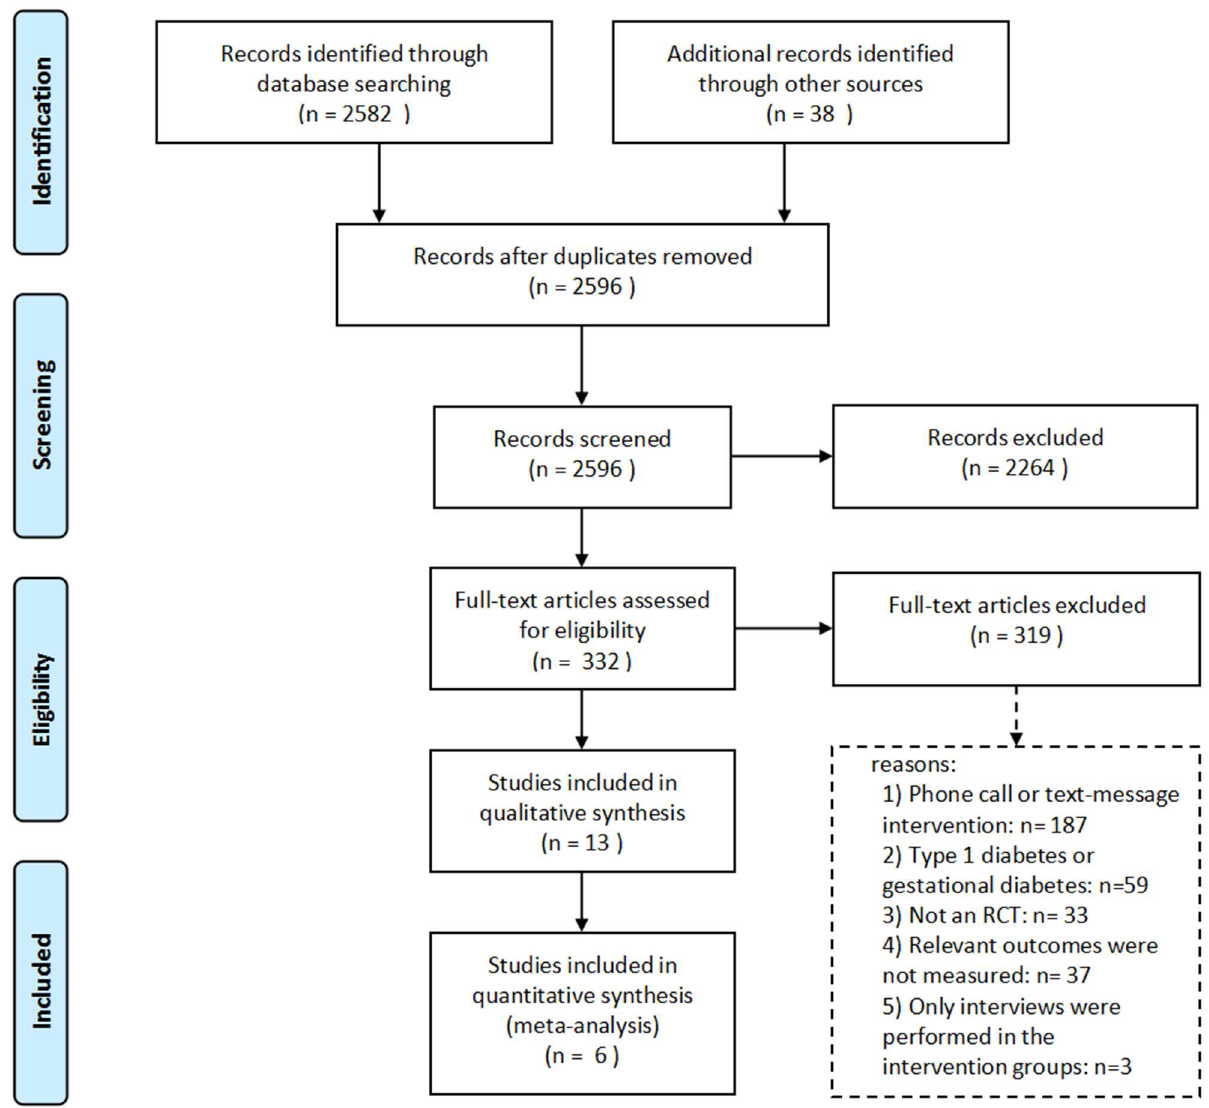
Fig 1. Flow diagram for the scientific paper selection from